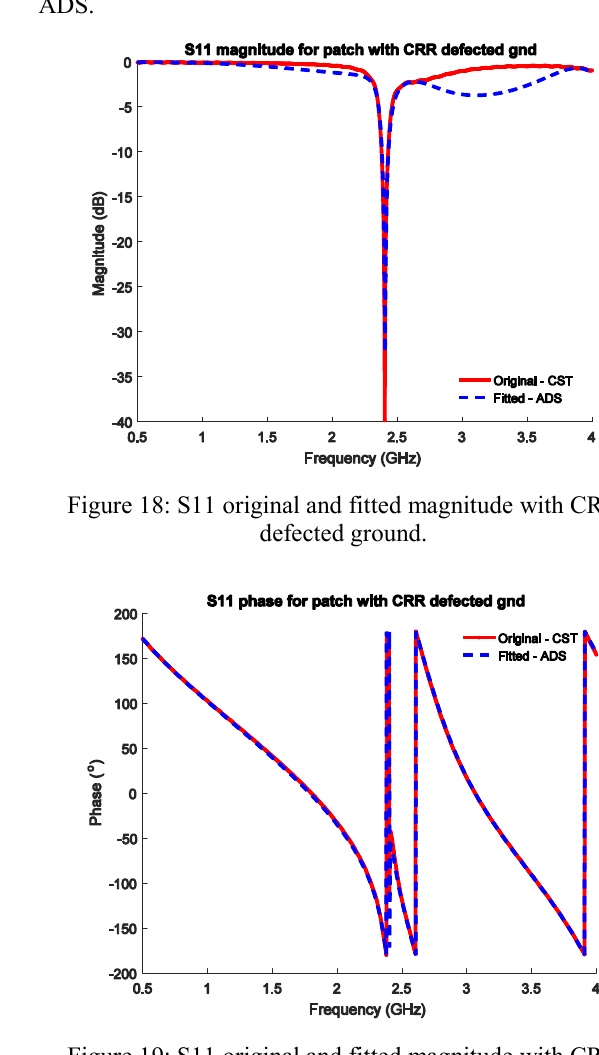
Figure 19: S11 original and fitted magnitude with CRR defected ground.